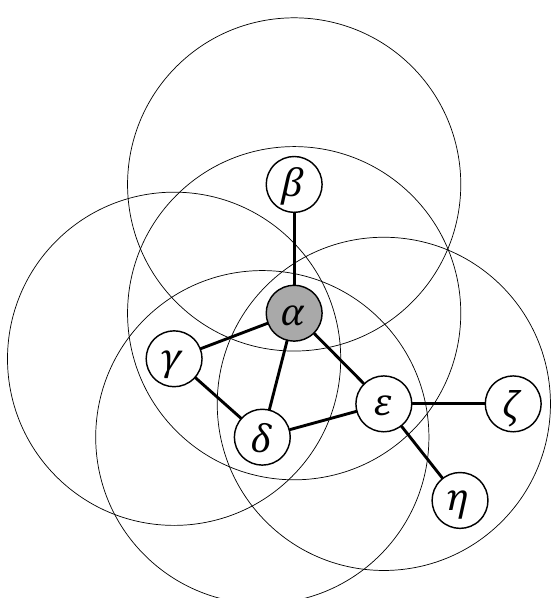
Figure 1. In the example, the node α has four direct neighbors ( β , γ , δ , (cid:101) ) and it thus participates in five PGGs, i.e. the circle centered in α involving { α , β , γ , δ , (cid:101) } , and four other PGGs represented by circles centered in its neighbors: { α , β } , { α , γ , δ } , { α , γ , δ , (cid:101) } , { α , δ , (cid:101) , ζ , η } . Note that a node may indirectly interact with other nodes that are not first